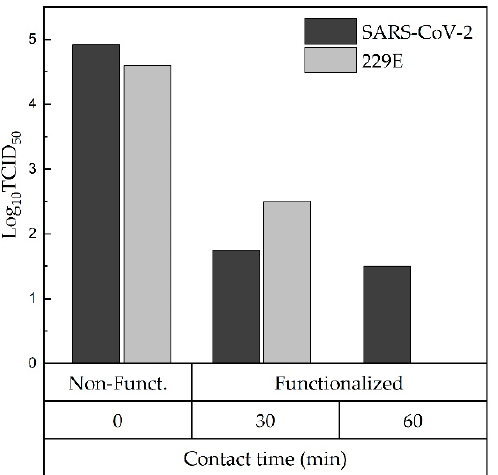
Figure 5. Achievement of TCID 50 -titres as a function of contact time of non-functionalized and functionalized fabrics with the SARS-CoV-2 and 229E viruses.